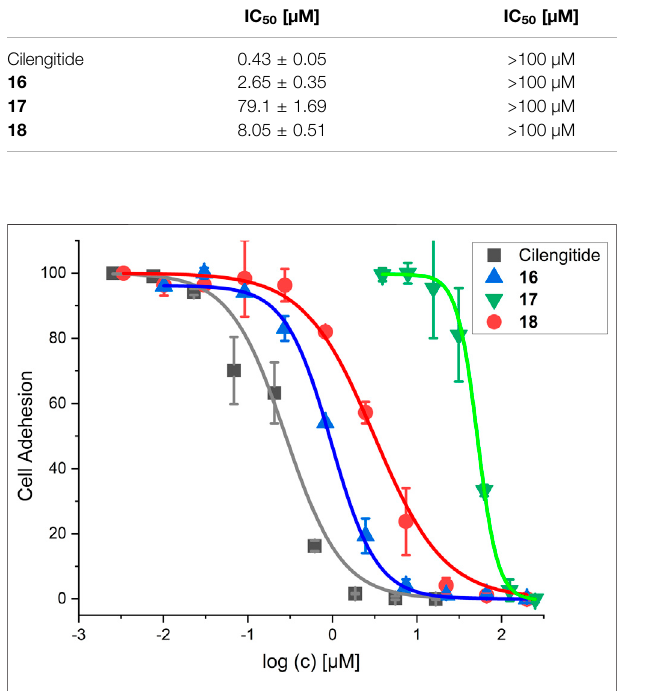
FIGURE 11 | Results for the cell adhesion assay against WM115 cells. For IC 50 values, see Table 6 .